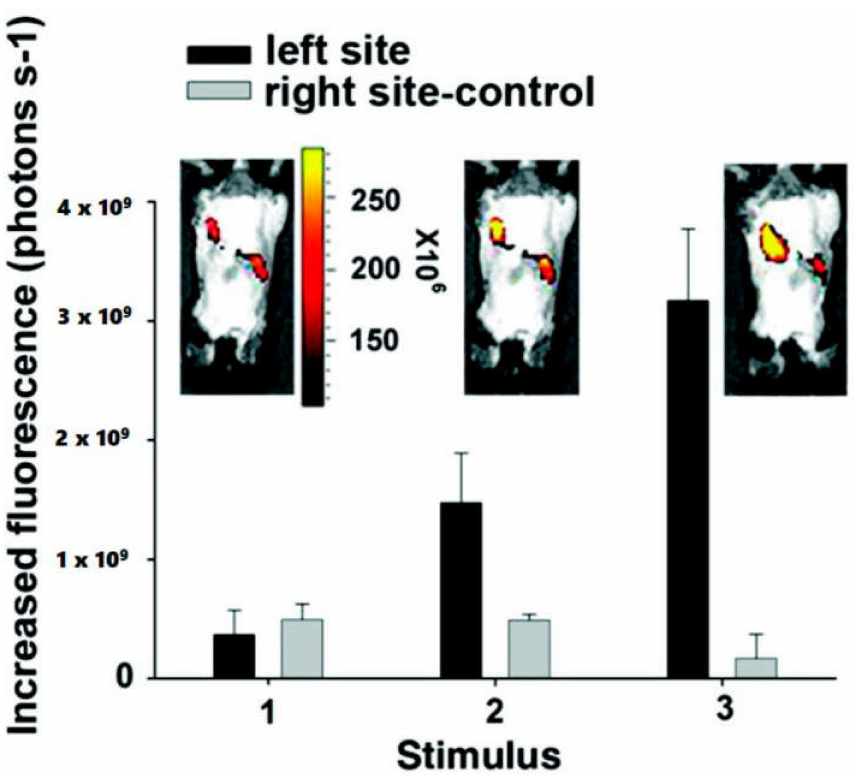
Figure 9. Fluorescent images of the implanted conductive hydrogel in vivo under an electric field of − 1.5 V / cm. The labels on the X -axis represent (1) before applying electric field and (2,3) after applying electric field on the left site of the imaged animals. The right side of each image is the control side without applying any electric field [72]. Reprinted from [72] with permission from American Chemical